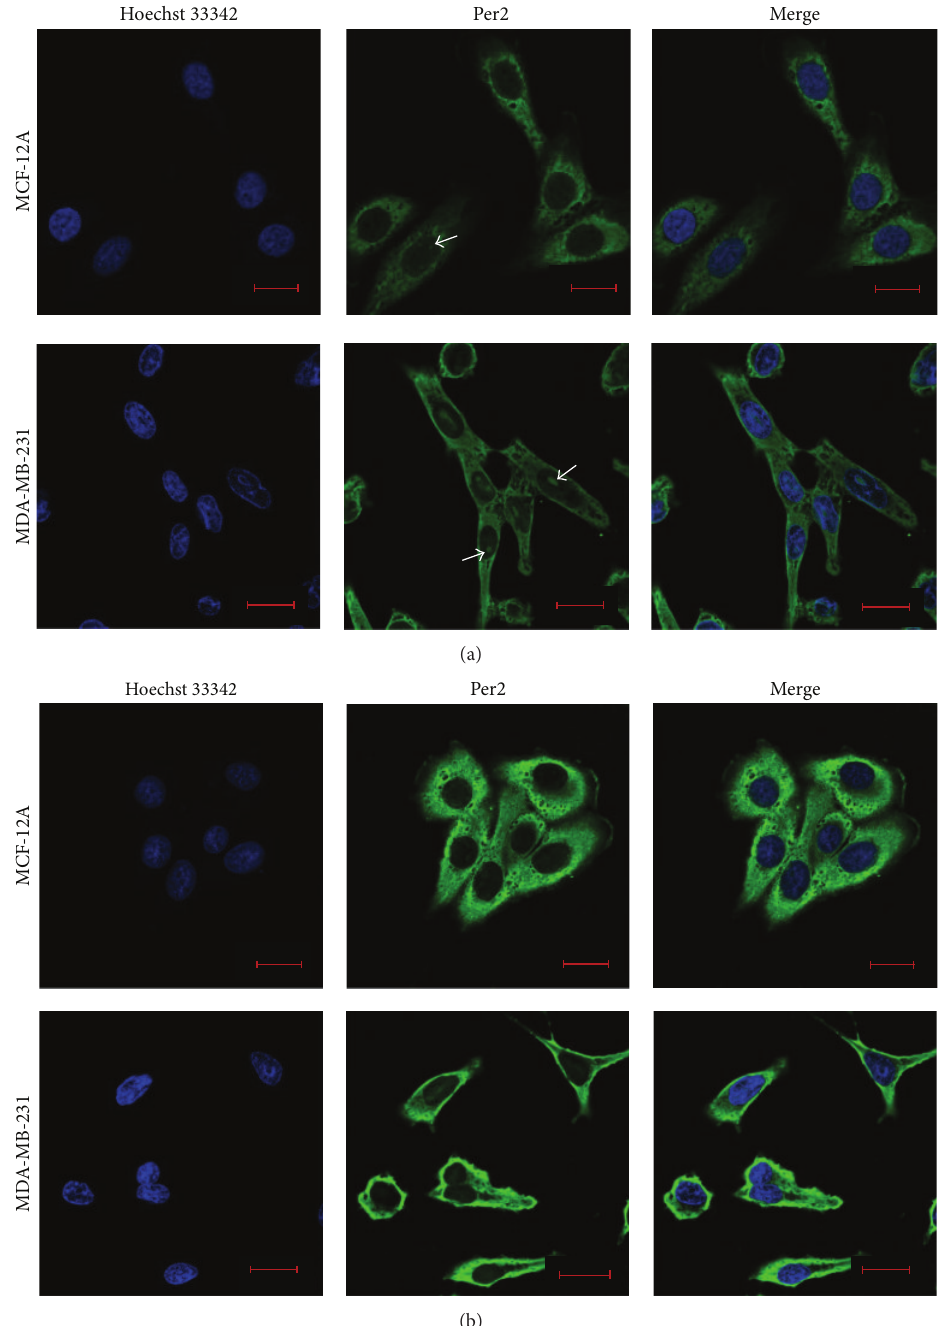
Figure2:DeterminationofPer2localization.BothMCF-12AandMDA-MB-231cellswereculturedunderstandardcontrolcellularconditions in 8-well chamber plates for a period of 24 hours. Cells were immunostained for Per2 (Green) and Hoechst 33342 (Blue) and visualized using fluorescent confocal microscopy at a 63x magnification. Two distinct populations of Per2 localization were observed in both the MCF-12A and MDA-MB-231celllines:(a)Per2nuclearlocalizationwasseeninthefluorescentlydimmercellpopulations;MCF-12Acellsshowslightnuclear localization; however this was more prominent within the MDA-MB-231 breast cancer cells. White arrows indicate nuclear localization of Per2. (b) Per2 was localized exclusively within the cytoplasm of the fluorescently brighter cell population in both cell